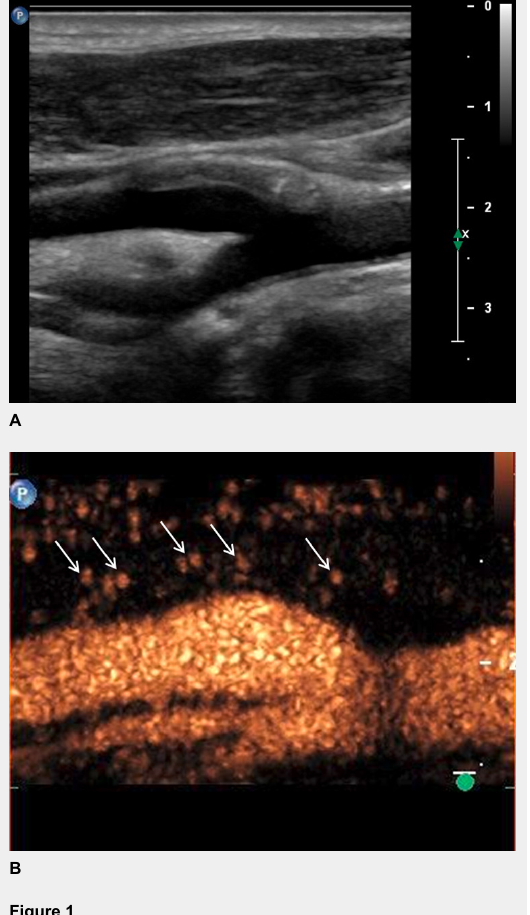
A 61-year-old patient with asymptomatic high-grade stenosis at the origin of the left internal carotid artery on colour Doppler ultrasound (A). Moderate intraplaque neovascularisation within the carotid stenosis at the near wall on CEUS imaging (arrows) and no neovascularisation at the far wall